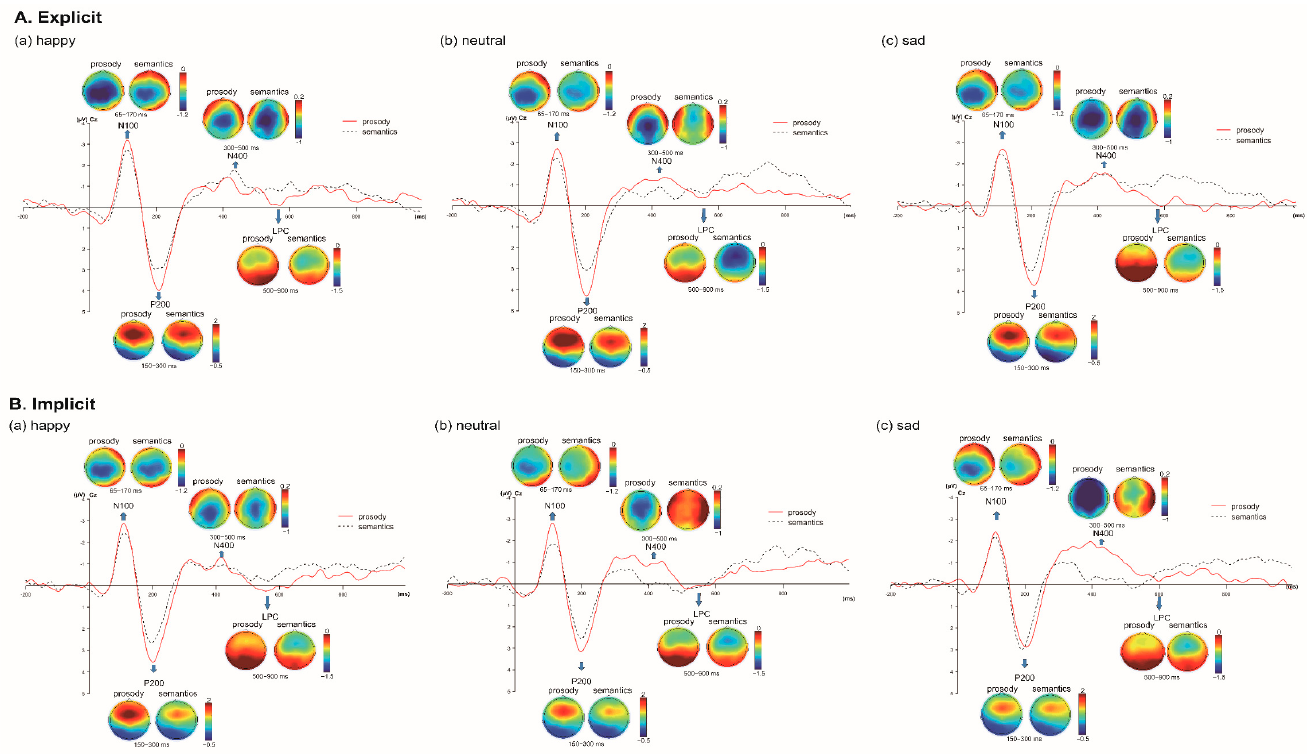
Figure 2. Grand averaged waveforms at Cz and topographical maps of mean amplitude in the N100, P200, N400 and LPC windows for ( a ) happy, ( b ) neutral and ( c ) sad stimuli in prosodic and semantic channels across ( A ) explicit and ( B ) implicit tasks.